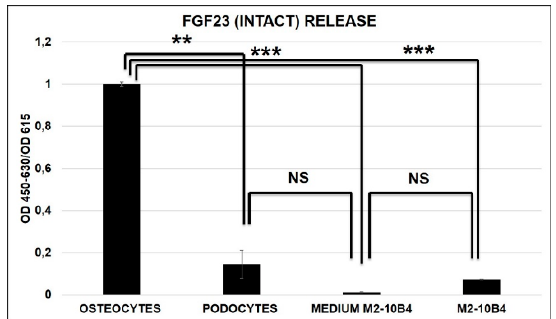
Figure 4. Cell cultured medium harvested from OS, PODO, M2-10B4, and basal medium for measurement of intact FGF23 release assessed by ELISA: ** p < 0.01, *** p < 0.001.